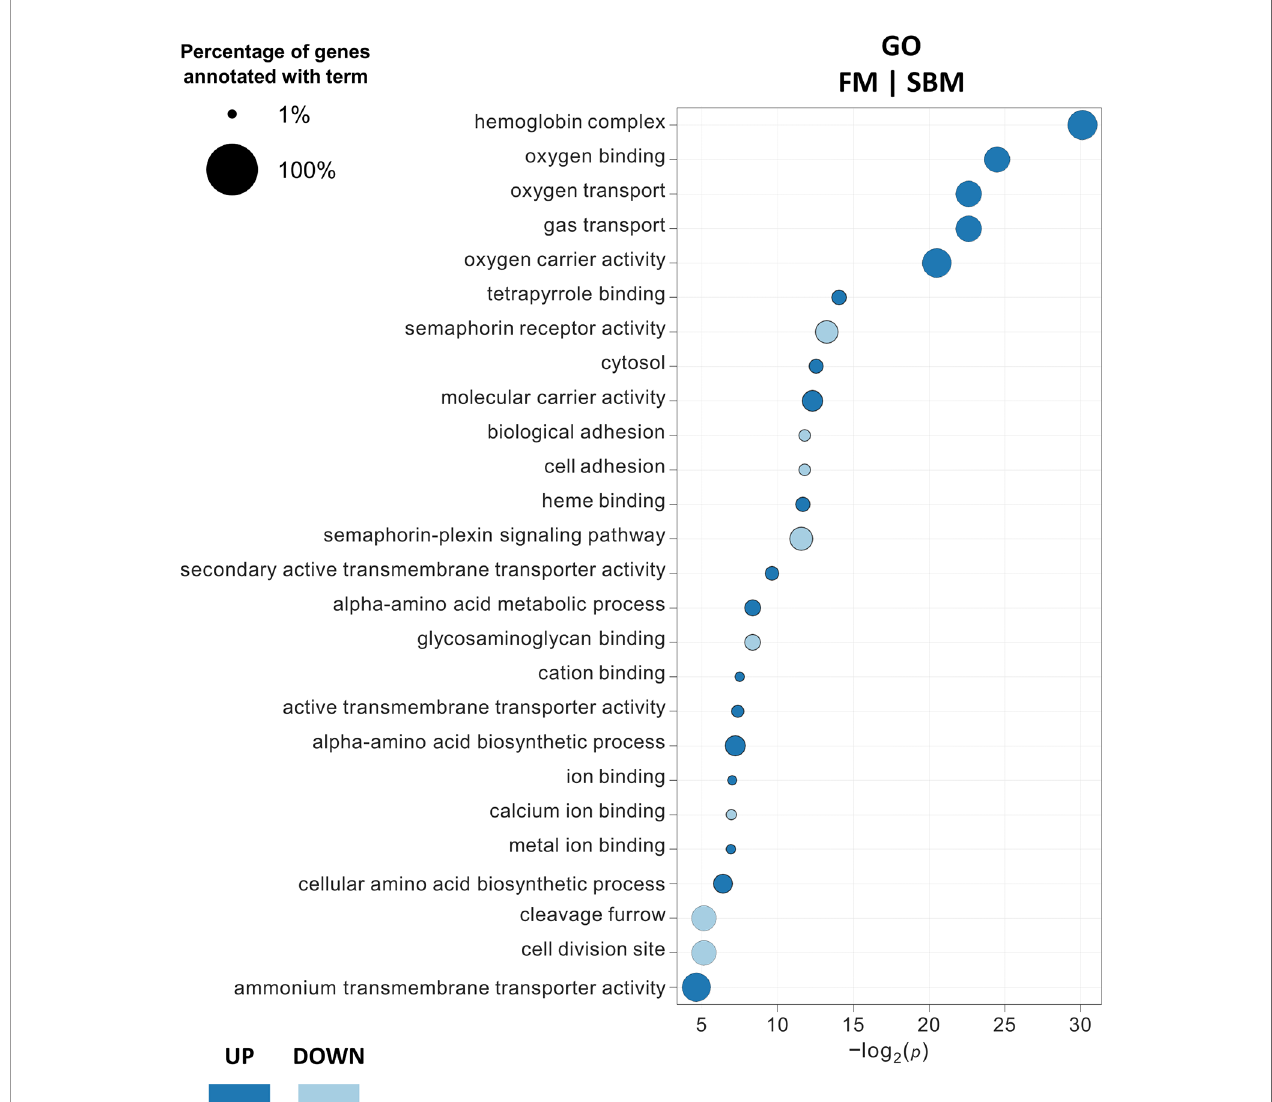
FIGURE 1 | Signi fi cantly enriched gene ontology (GO) terms (minGSSize = 3) in spleen of fi sh fed FM diet compared to SBM. The list is ordered by -log 2 ( p ). Up, up- regulated (in blue); Down, down-regulated (in light